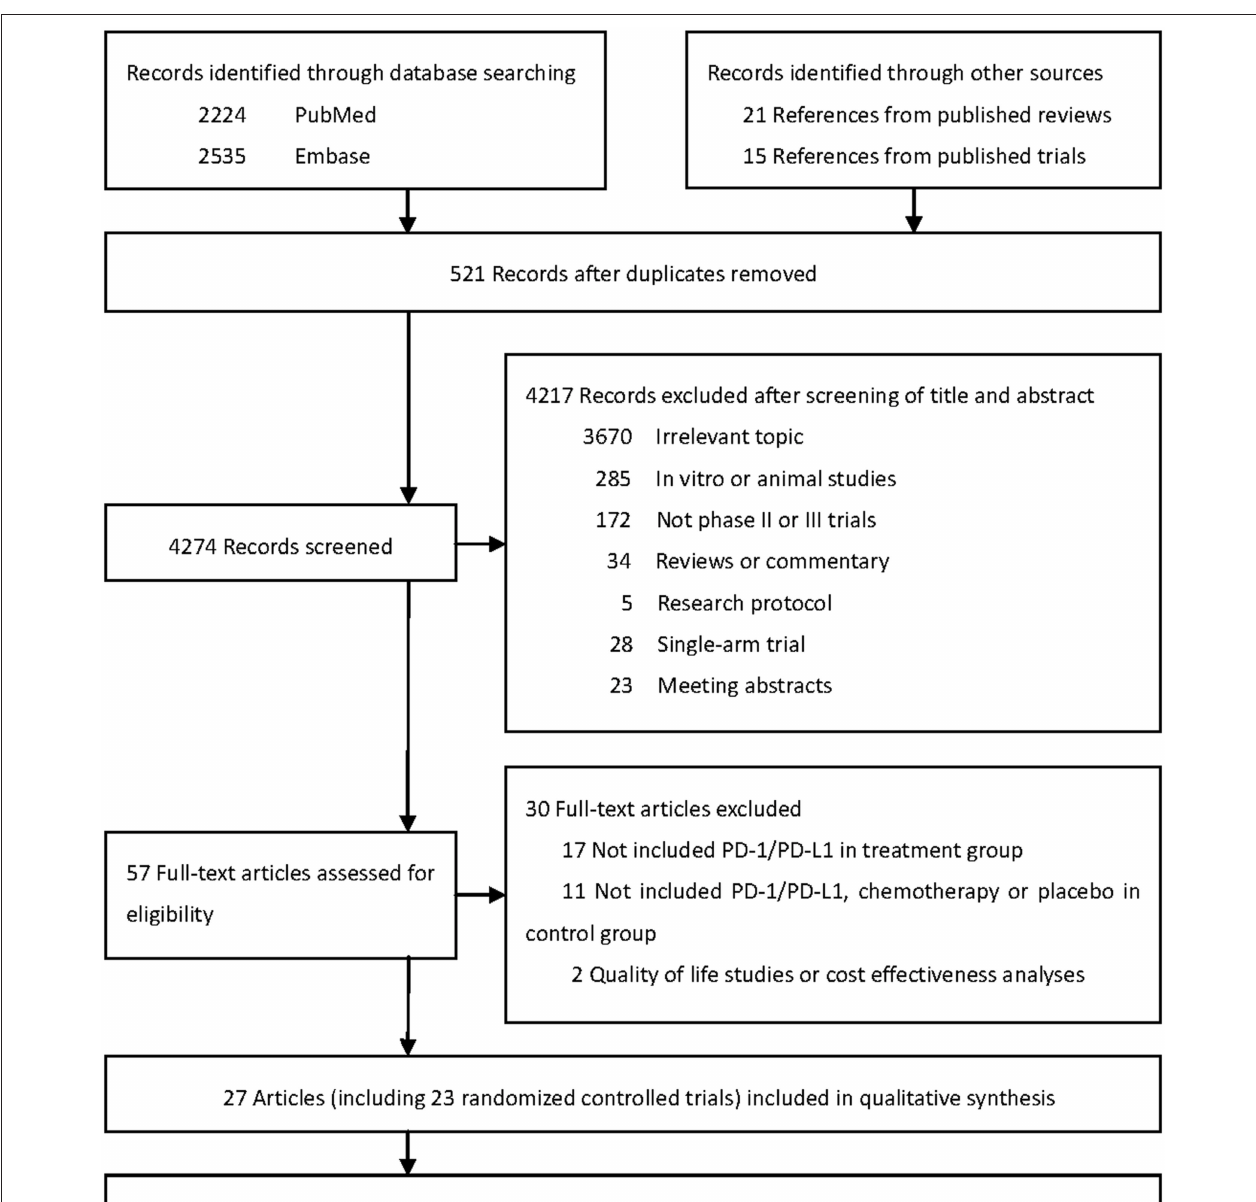
FIGURE 1 | Literature search and selection.